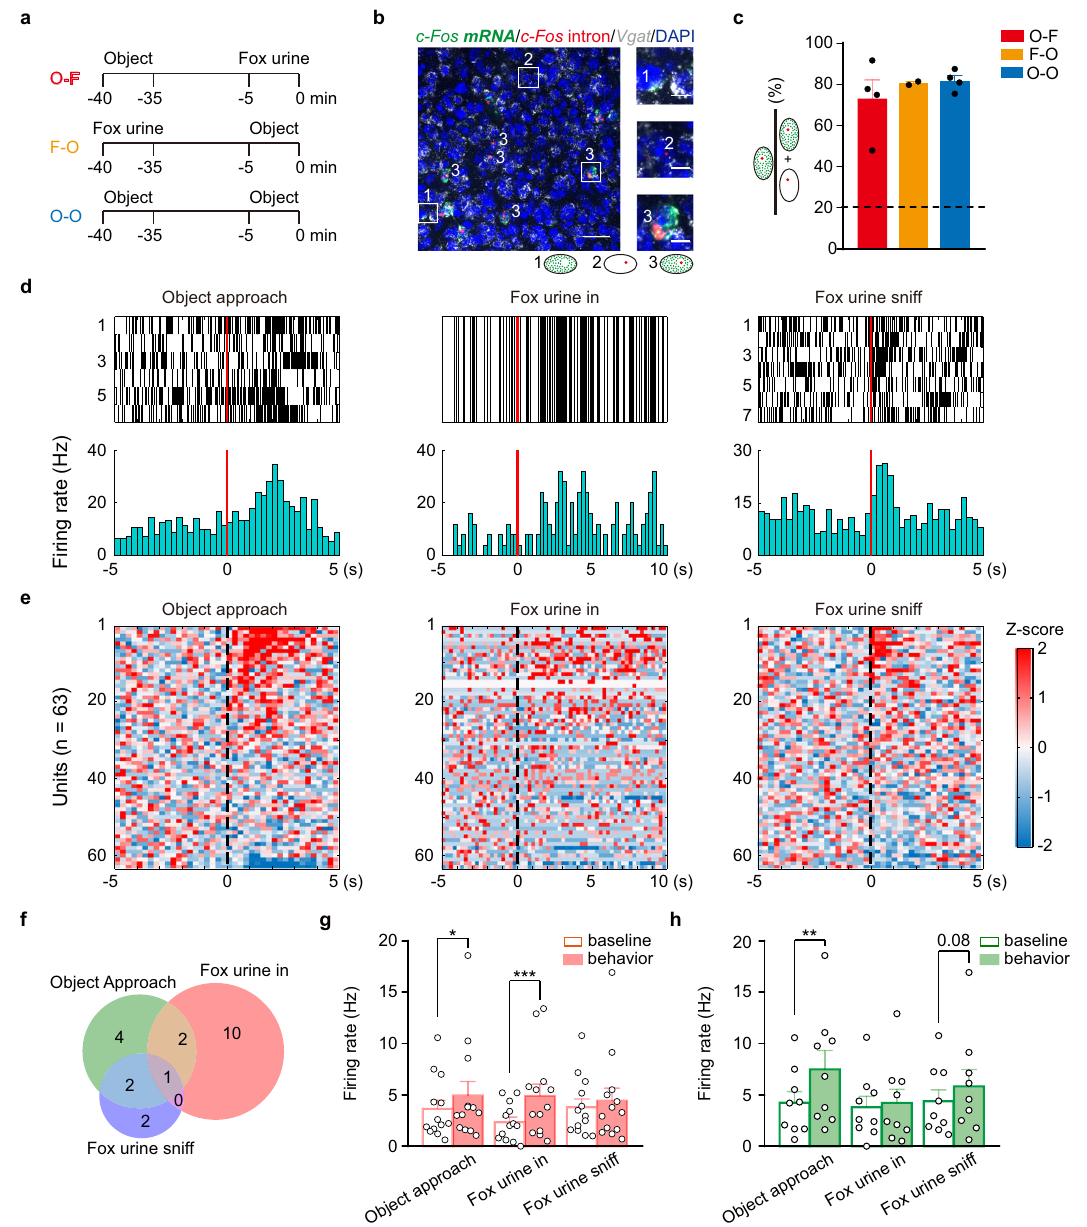
Fig.4|OverlappingAHNneuralensemblesrespondtoanobjectandapredator cue.a – c catFishanalysisofAHN Vgat+